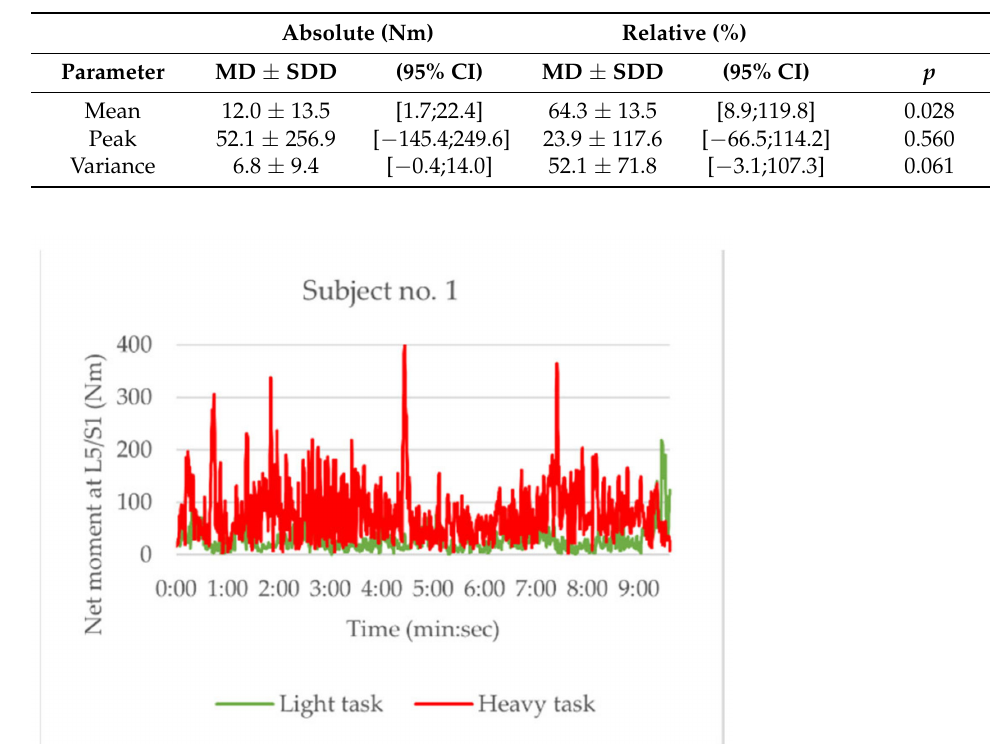
Figure 2. Typical example of net moment curves during light (green) and heavy (red) tasks (Subject 1).